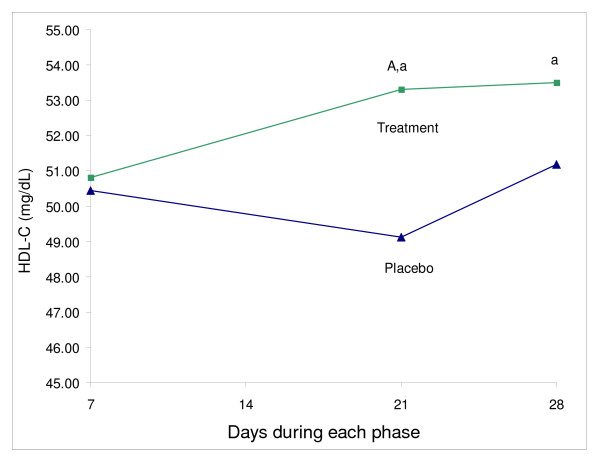
The effect of plant sterol ester on HDL – cholesterol (mg/dL) (N = 16). A Significantly different from placebo, p < 0.05 (paired t-test) a Significantly different within phase, p < 0.05 (1-way repeated measure ANOVA)